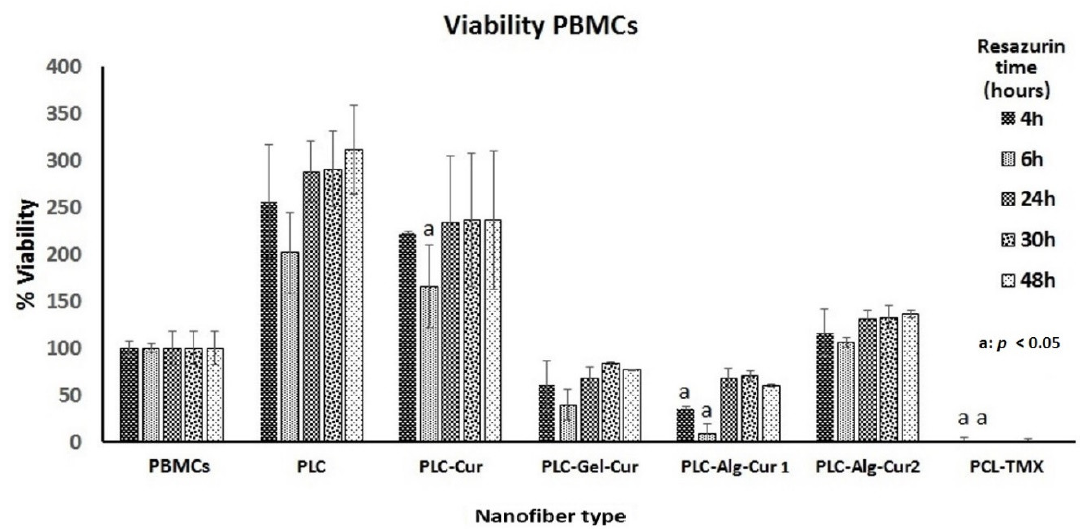
Figure 10. Viability percentage of PBMCs cells treated with the different nanofibers for 24 h. The reduction in resazurin to resorufin was measured at 24 h. The student’s t -test was used to establish significance.